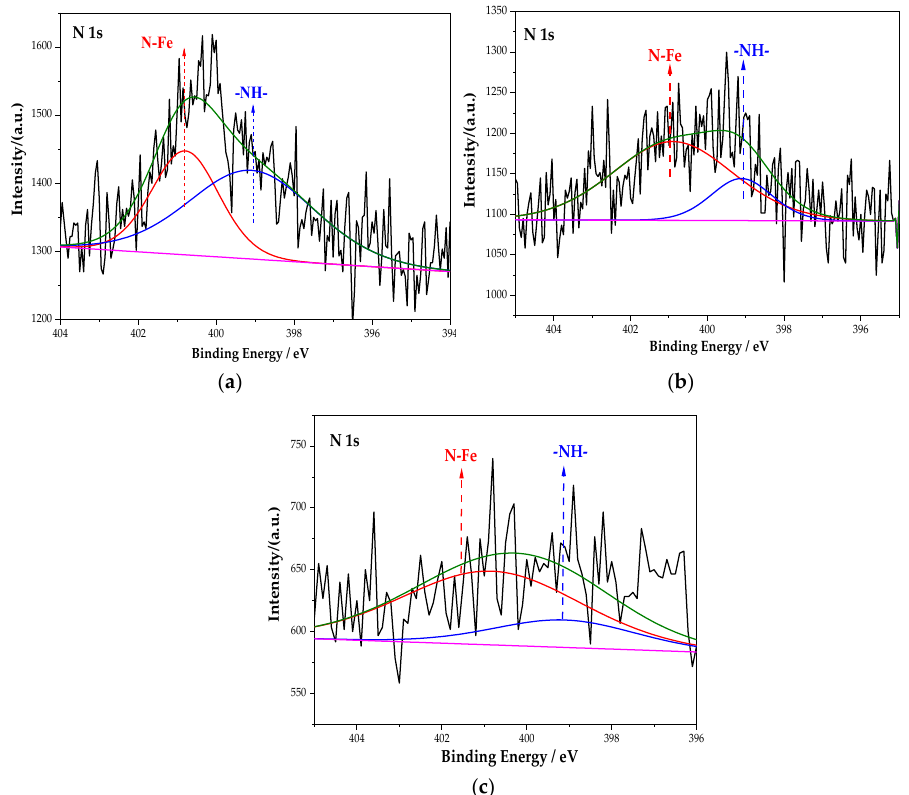
Figure 6. XPS peak spectrum of the N element in the passive film under the action of different rust inhibitors. ( a ) BTA group. ( b ) Na 2 CrO 4 + BTA group. ( c ) Na 2 MoO 4 + BTA group. Table 5. Fitting data of N element in different test groups.